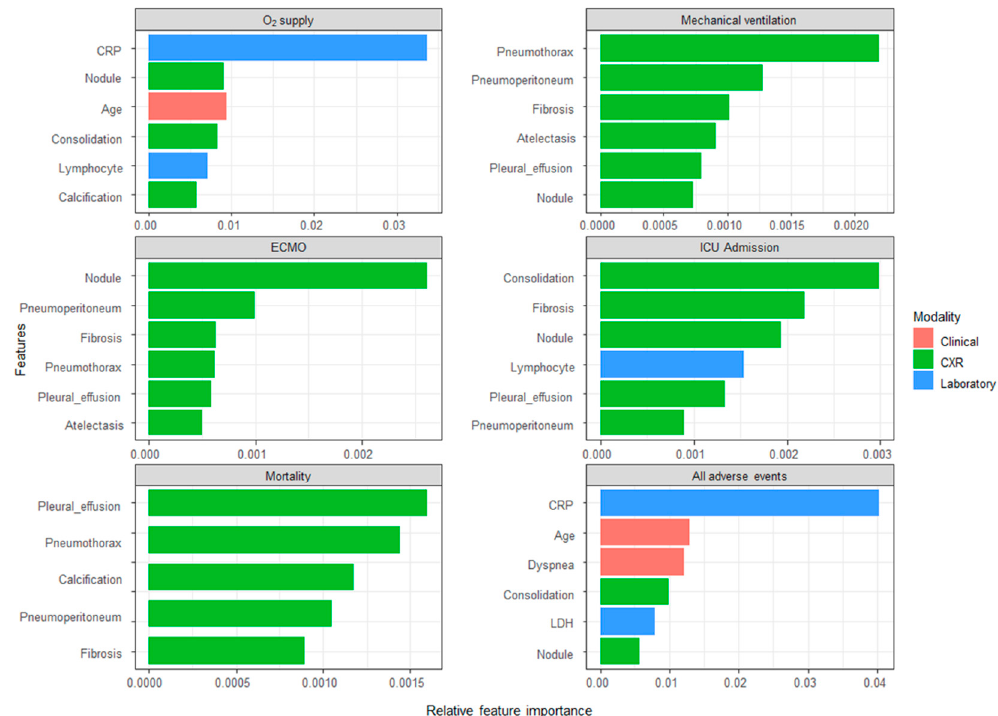
Figure 3. Importance of relative features to predict events.